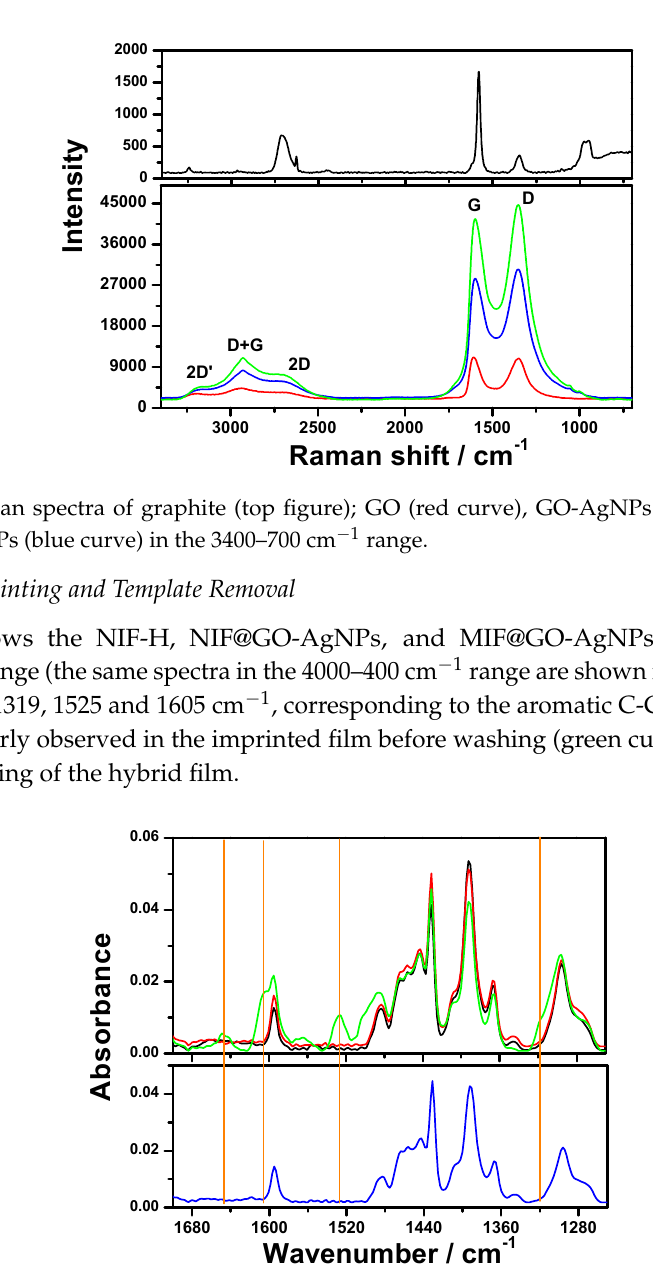
Figure 3. FTIR spectra of NIF-H (black curve), NIF@GO-AgNPs (red curve), and MIF@GO-AgNPs samples before (green curve) and after washing (blue curve, bottom figure).